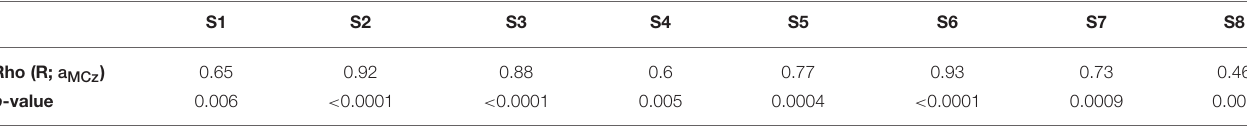
TABLE 1 | Coefficient of correlation of Spearman between R and of a MCz (m/s 2 ).